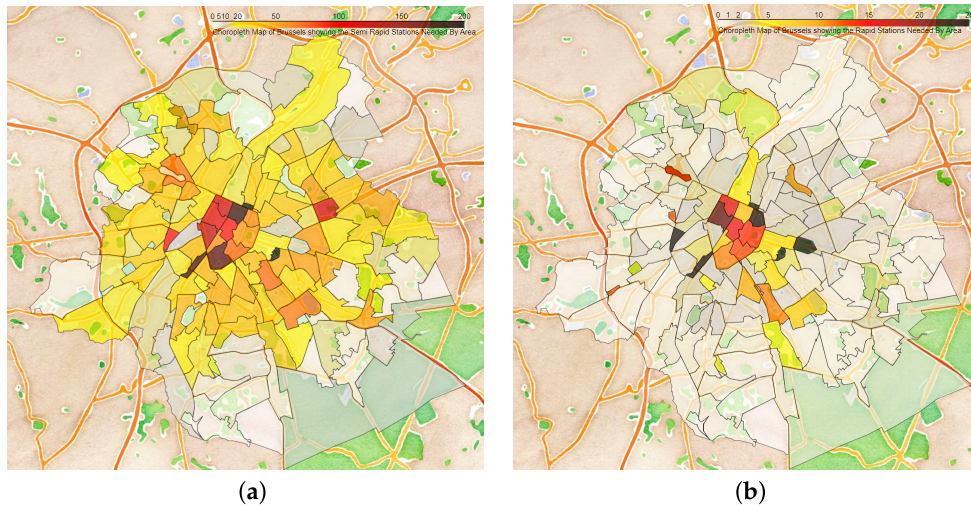
Figure 10. Number of semi-rapid and fast charging stations needed for each technology. The number of stations are normalized by the neighborhood’s area to facilitate data interpretation and visual- ization. (Units: number of stations/km 2 ). ( a ) Number of semi-rapid charging stations needed in Brussels normalized by each neighborhood’s area. ( b ) Number of fast charging stations needed in Brussels normalized by each neighborhood’s